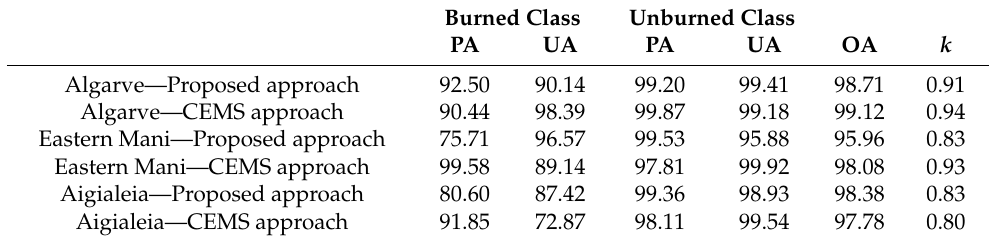
Table 2. Accuracy metrics for all study areas per approach.